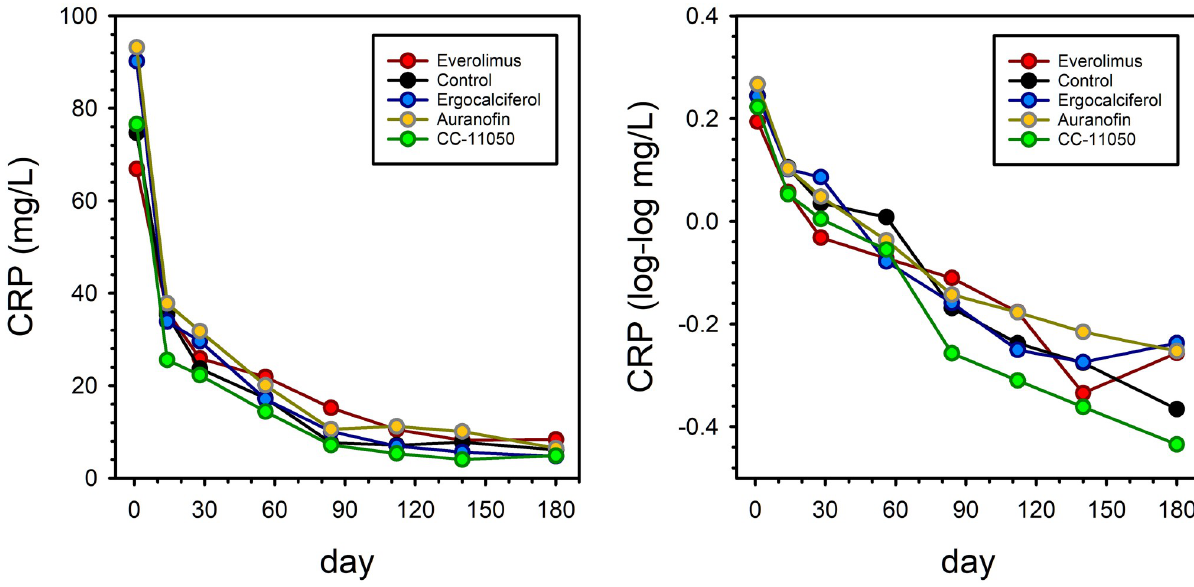
Fig 3. Treatment effects on CRP before and after log-log transformation. Symbols indicate mean values.